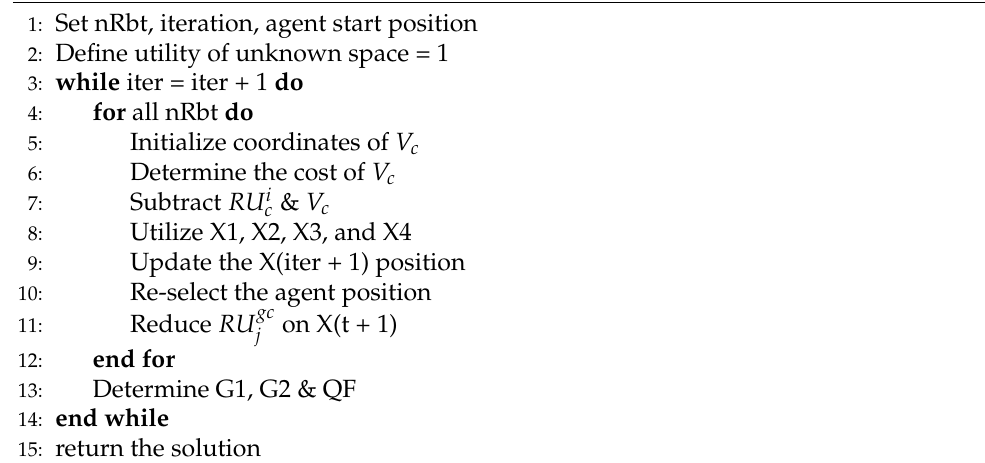
Algorithm 1 Integrated CME-Adaptive Aquila Optimizer.